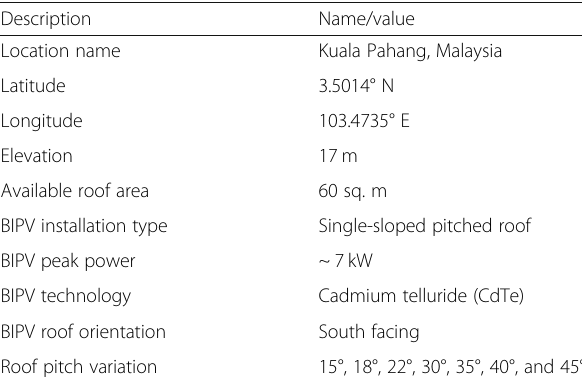
Table 1 Study location, area availability for BIPV roof, and